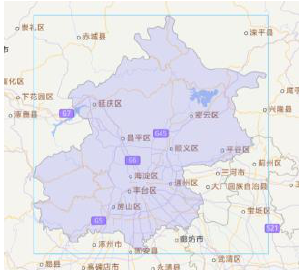
Figure 7. Experimental data and extent